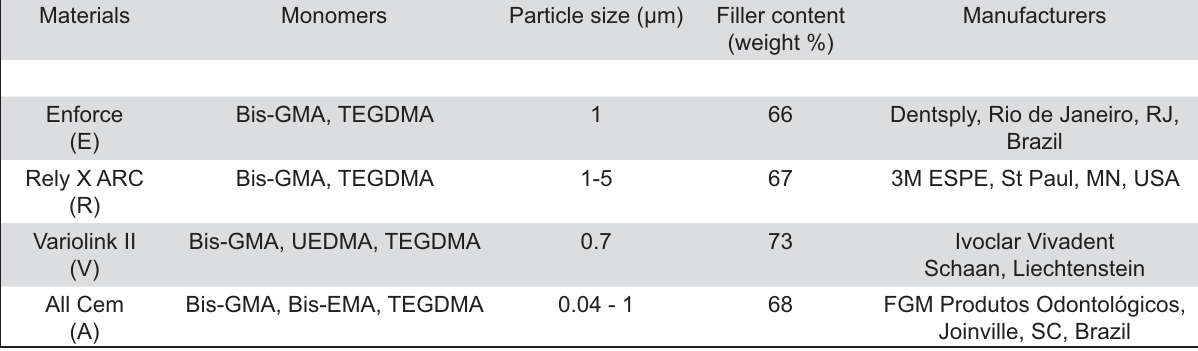
studyBis-GMA: 2,2-bis[p-(2’-hydroxy-3’methacryloxypropoxy)phenyl]propane; TEGDMA: triethylene glycol dimethacrylate; Bis-EMA: ethoxylated bisphenol A dimethacrylate UEDMA: 1,6-bis(methacryloxy-2-ethoxycarbonylamino)-2,4,4- Figure 1- Resin-based luting cements used in this